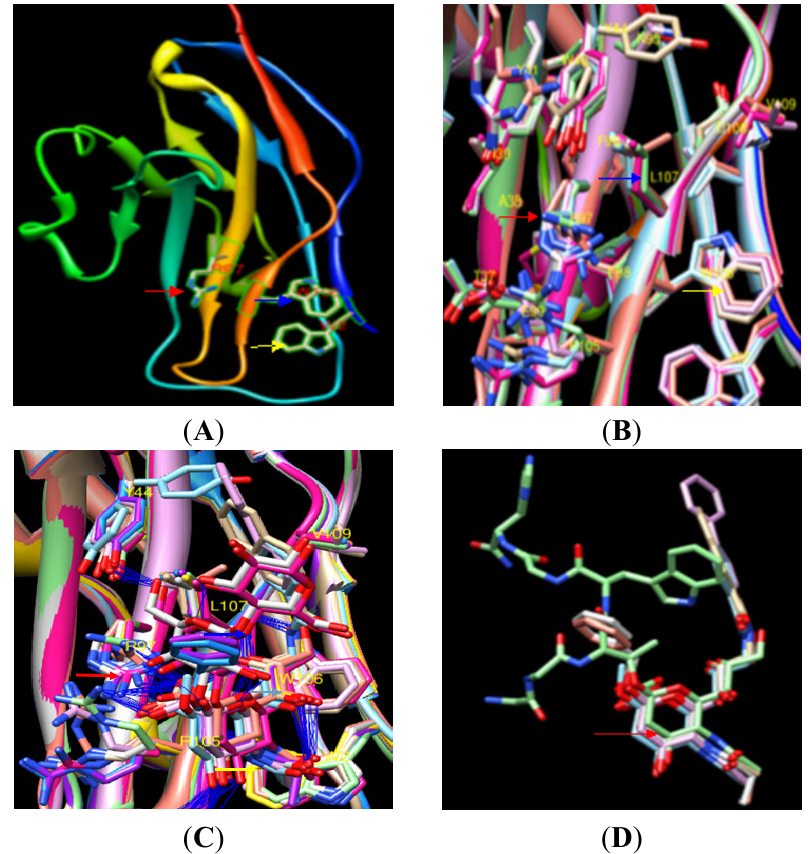
Figure 1. Skeleton model of the interaction of mSN with mouse sialic acid ligands. ( A ) Key amino acids in mSN have previously been reported to bind to sialic acid, including R97 (red arrow), W106 (blue arrow) and W2 (yellow arrow); ( B ) The backbones of six templates with their ligands deleted were superimposed using Chimera software (version 1.6.2, University of California, San Francisco, CA, USA, 2012); ( C ) The backbones of six templates along with their ligands were superimposed; Hydrogen bond interactions between ligands and mSN are denoted by a blue line. R97 (red arrow), W106 (blue arrow) and W2 (yellow arrow); ( D ) Ligand superimposition indicated that the position of the Neu-5Ac α ligand core (red arrow) was